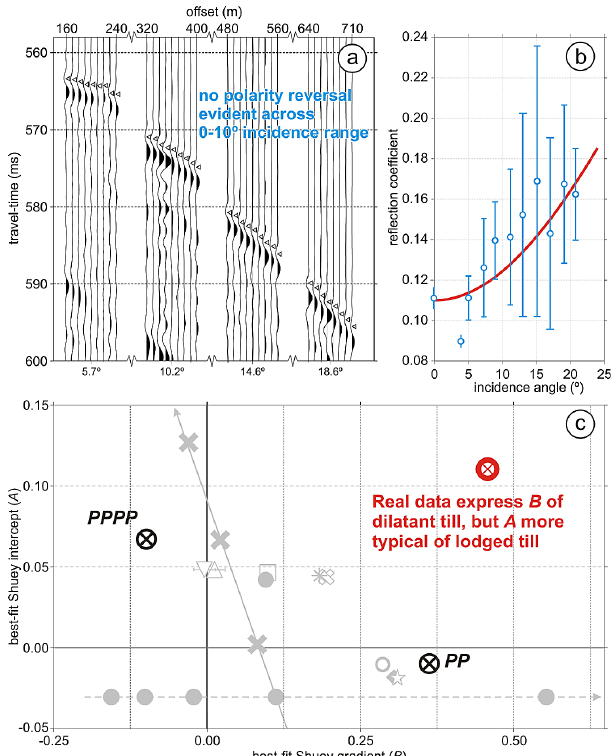
Fig. 6. AVA analysis of real data. from Russell Glacier, Greenland. (a) Representative seismic supergather, in which the basal reflection exhibits no polarity reversal. Grey triangles show location of ampli- tude picks. (b) AVA response of the basal reflection. Blue points are the observed AVA data, red curve is the best-fit curve follow- ing Bayesian statistical analysis. (c) AVA cross-plot. Best-fit Shuey quantities to real data (red) show positive A - and B -terms. Black points show reference A - and B -terms for PP and PPPP models, and model responses from Figs. 1c and 5c are shown (grey) for